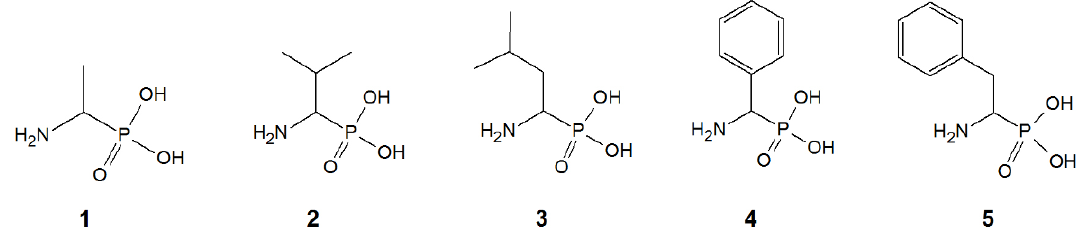
Figure 1. Structures of tested aminophosphonic